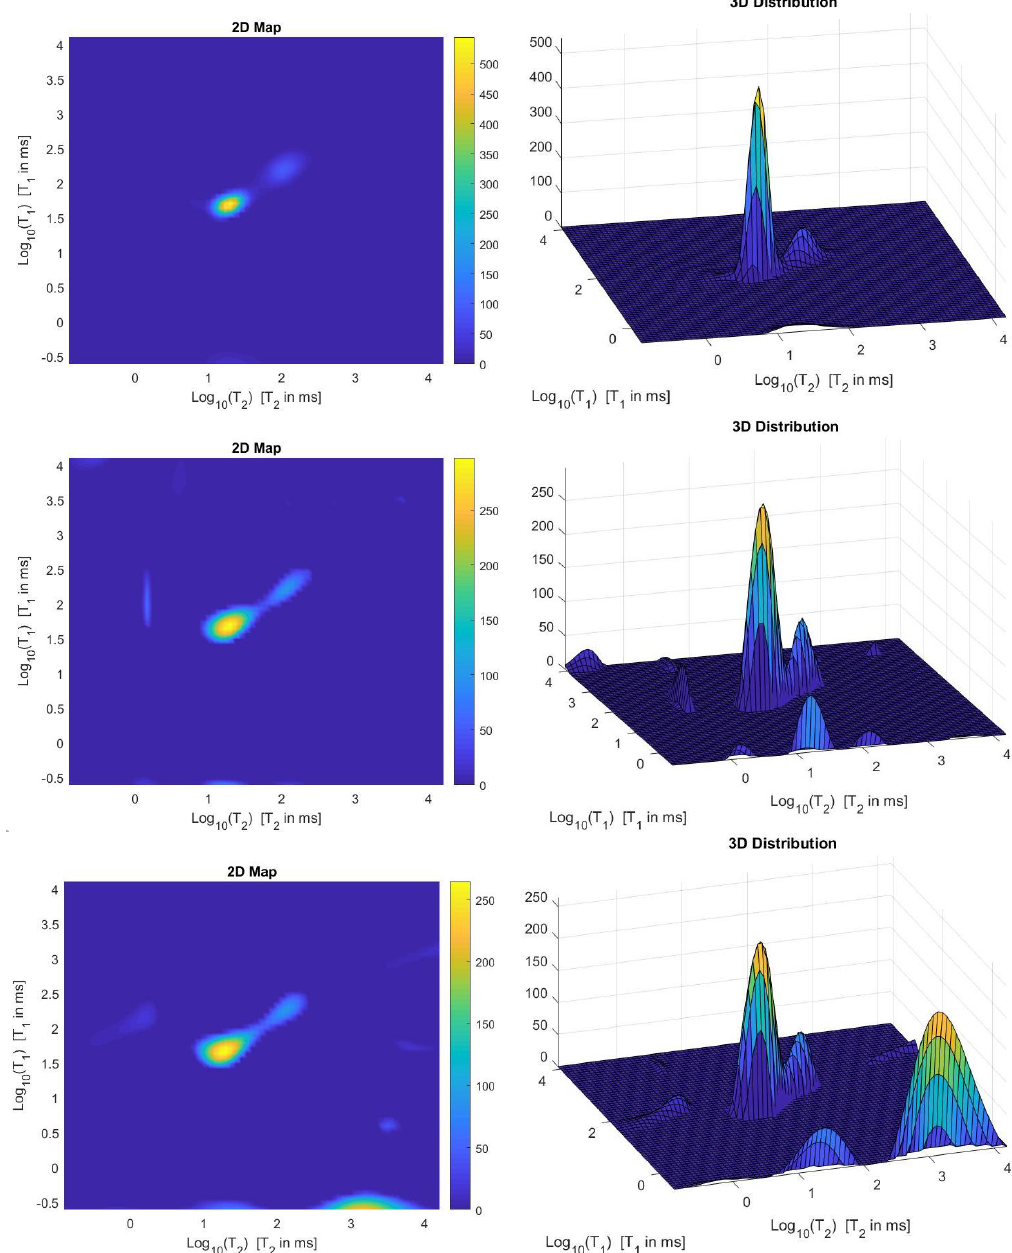
Figure 12. From top to bottom : UPEN, Hybrid and VSH restored T 1 – T 2 maps ( left ) and surface distributions ( right